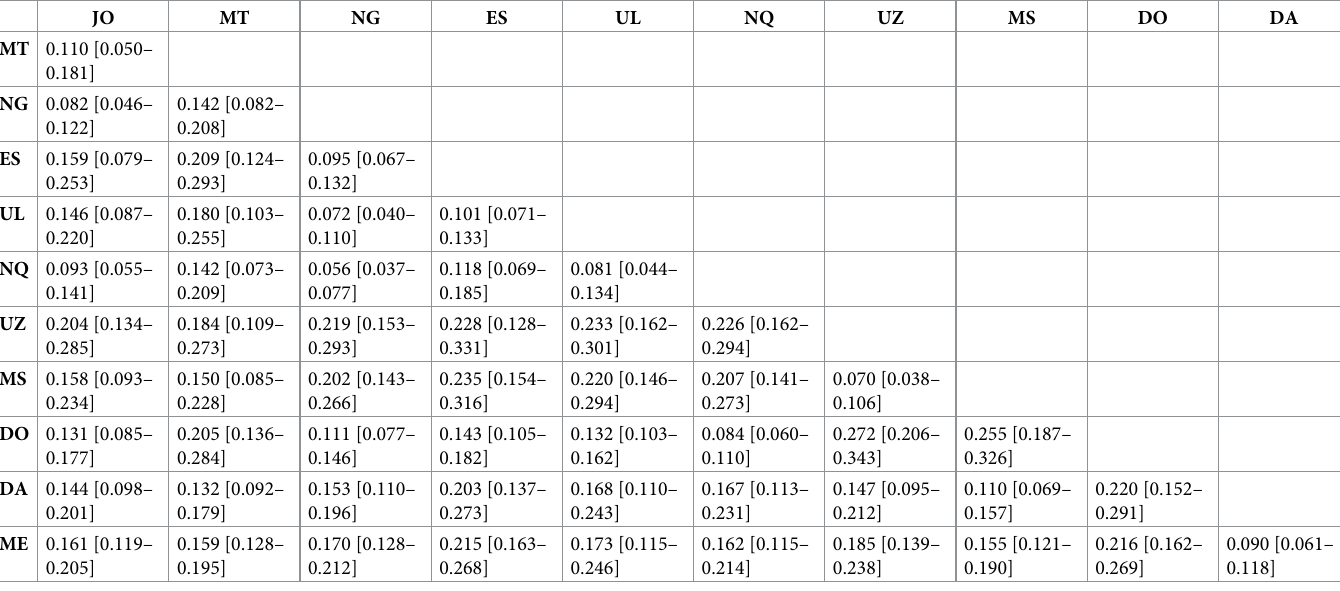
Table 2. Pairwise F ST among the studied breeds/populations (with confidence intervals at